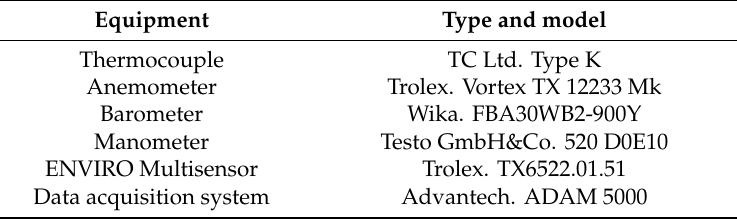
Figure 3. Section of the testing drift with the sensors, T, at different heights. Table 1. Characteristics of the sensors.